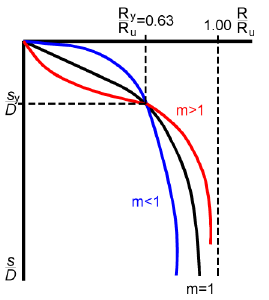
Fig. 6. Variable definitions of the Weibull curve (Takagi et al. 2007)